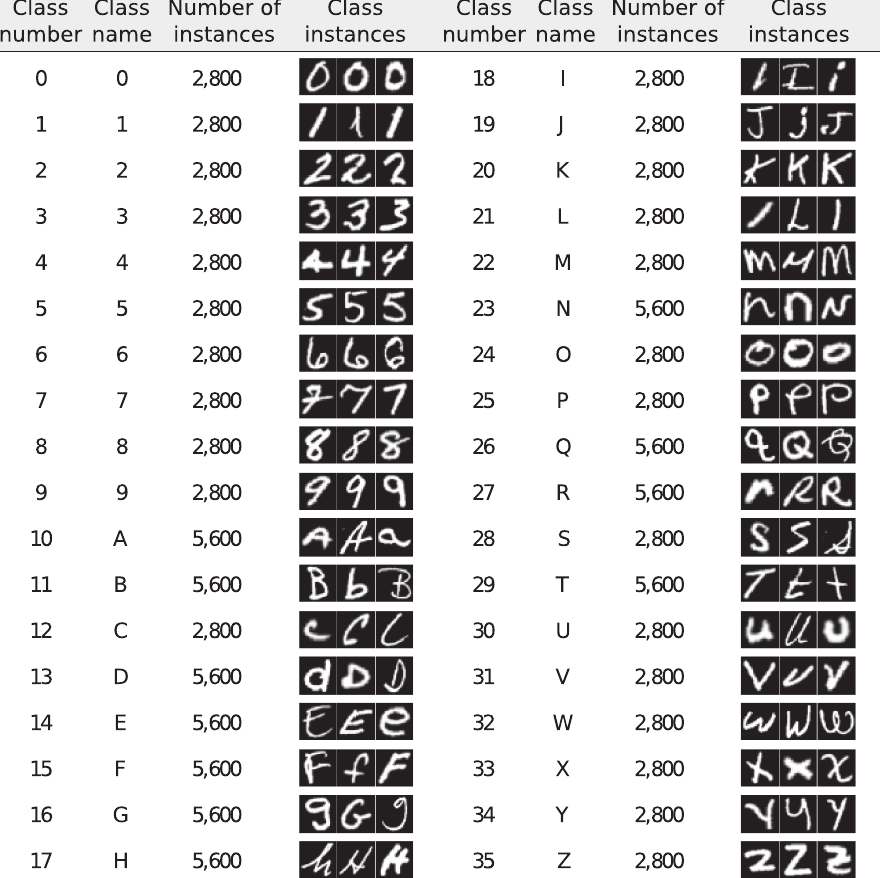
Fig 6. EMNIST-36